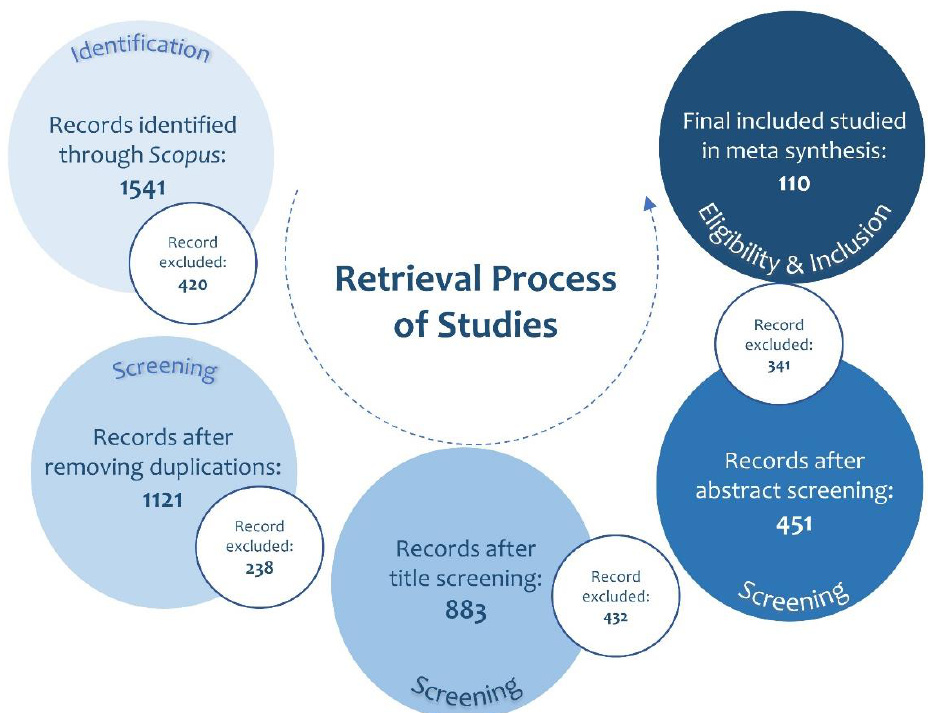
Figure 1. Flowchart for retrieval of studies.